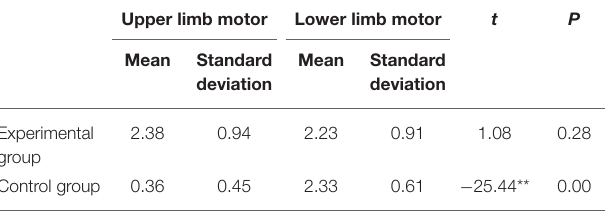
TABLE 3 | Comparison of the upper limb and lower limb motors between the experimental and control groups. Upper limb motor